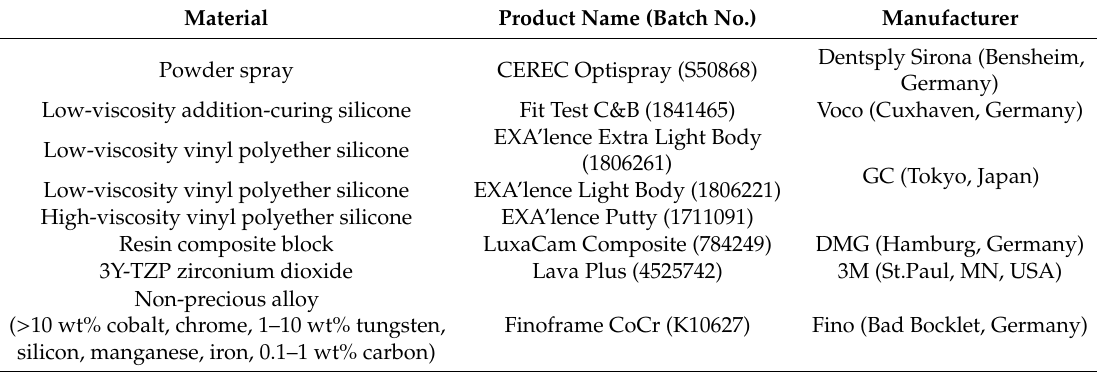
Table 1. Materials used in this study (information provided by the